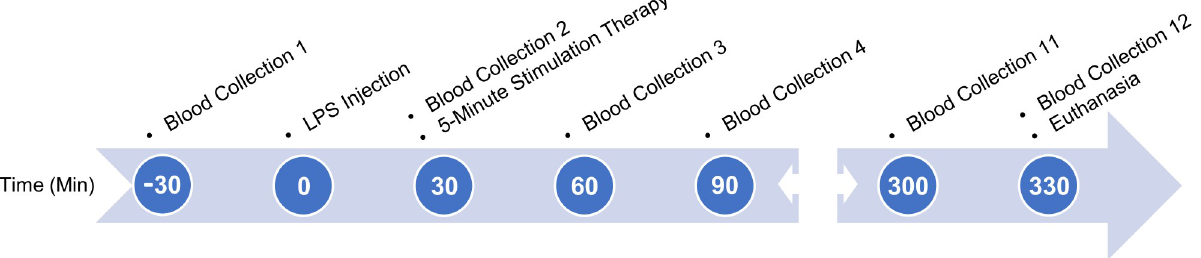
Fig 1. Time flow diagram outlining the experimental process. Process included blood collection, LPS administration, and stimulation treatments (if applicable). Time points are based in relation to the acute LPS challenge to the animal.